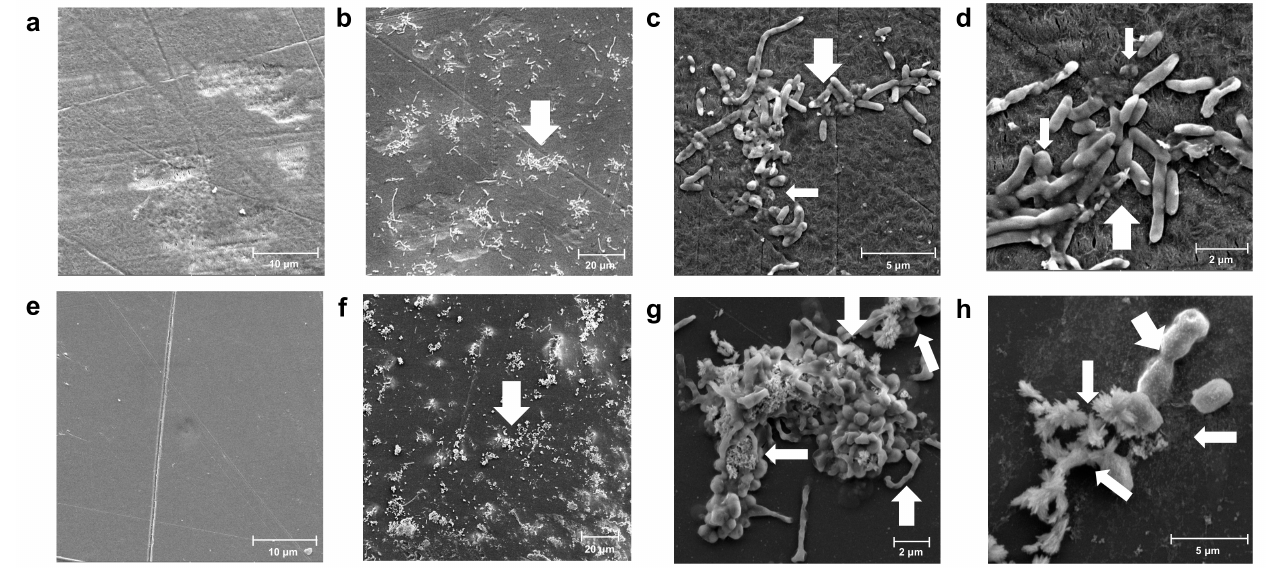
Figure 4. Colonization of different polymers by Exiguobacterium sp. RIT 594. The surfaces of high- density polyethylene (HDPE) ( a – d ) and of PS ( e – h ), were recorded following 60 days of shaking in minimal medium (LCFBM) lacking a carbon source other than the polymer. ( a ) Control without bac- terial inoculation (4980 × resolution, scale bar 10 µ m); ( b – d ) colonized HDPE by Exiguobacterium sp. RIT 594. ( b ) Colonies of the bacterium at 1760 × resolution and scale bar at 20 µ m (white arrow); ( c , d ) represent snapshots of ( b ) at magnifications of 11,200 and 20,300 × , and scale bars at 5 and 2 µ m, respectively. The typical short, rounded morphology is highlighted with thinner white arrows, and the elongated rods with thicker white arrows. The cell shape is possibly elongated due to the inability to use HDPE as a carbon source (starvation response; see text for details). ( e ) Control without bacterial inoculation (5000 × resolution, scale bar 10 µ m), 60 days shaking in minimal medium (LCFBM), and ( f – h ) colonized by Exiguobacterium sp. RIT 594. ( f ) Colonies of the bacterium at 1400 × resolution and scale bar at 20 µ m (white arrow). ( g ) Further magnification of ( f ) reveals that the cells are associated with nanoscale fibers and particles (thinner white arrows) and cell elongation (thicker white arrows); 13,700 × resolution, scale bar 2 µ m. ( h ) Multiple cells adhere to a cell with a single long projection (thicker white arrow), which is associated with nanoscale fibers and particles (thinner white arrows; 29,500 × resolution, scale bar 2 µ